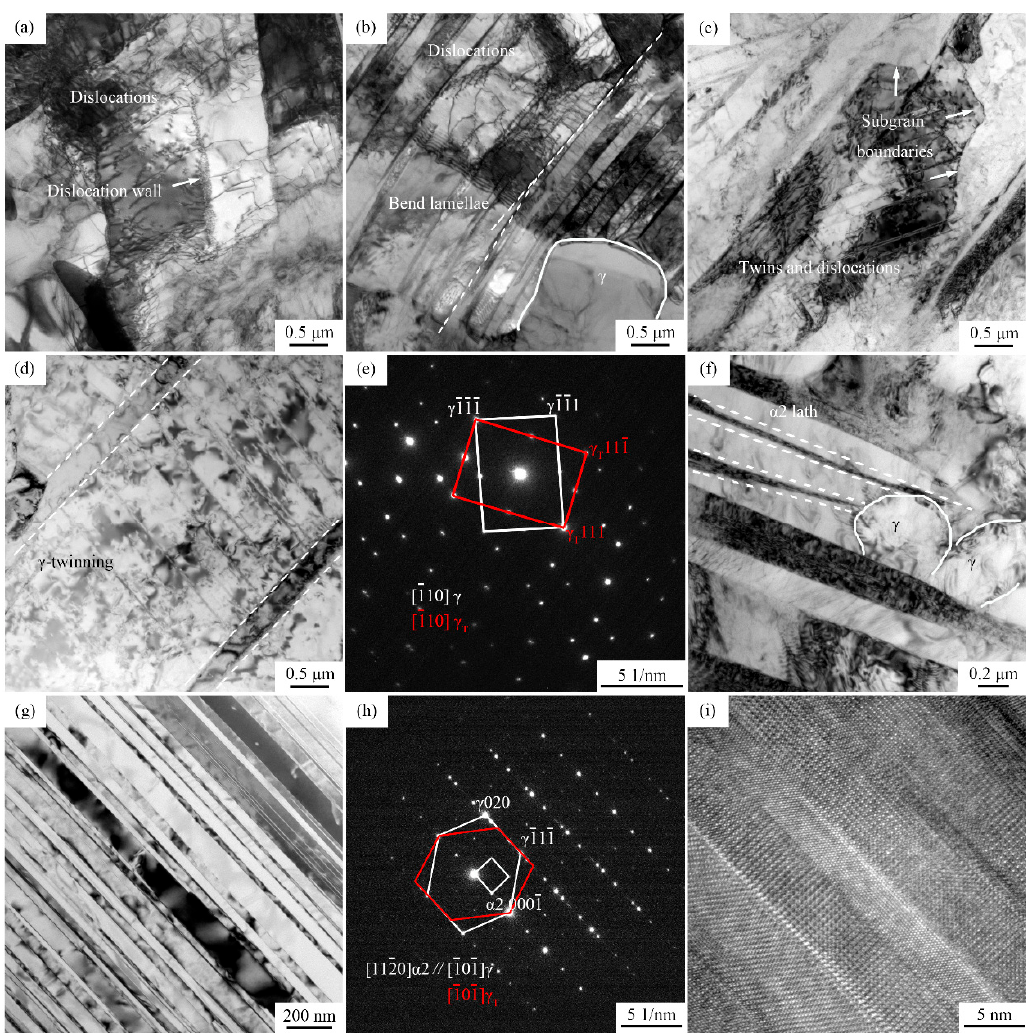
Figure 10. TEM analysis of Ti-44Al-5Nb-1Mo-2V-0.2B alloy deformed at 1200 °C/0.1 s − 1 at strain of 50%: ( a ) dislocations in γ grains; ( b ) fragmented lamellae; ( c – e ) mechanical twins in γ laths and the selected area electron diffraction (SAED) pattern; ( f ) decomposition of α 2 laths; ( g , h ) the bright-field image of nano α 2/ γ lamellae and its SAED pattern; ( i ) the high-resolution transmission electron microscopy (HRTEM) image of nano α 2/ γ lamellae.